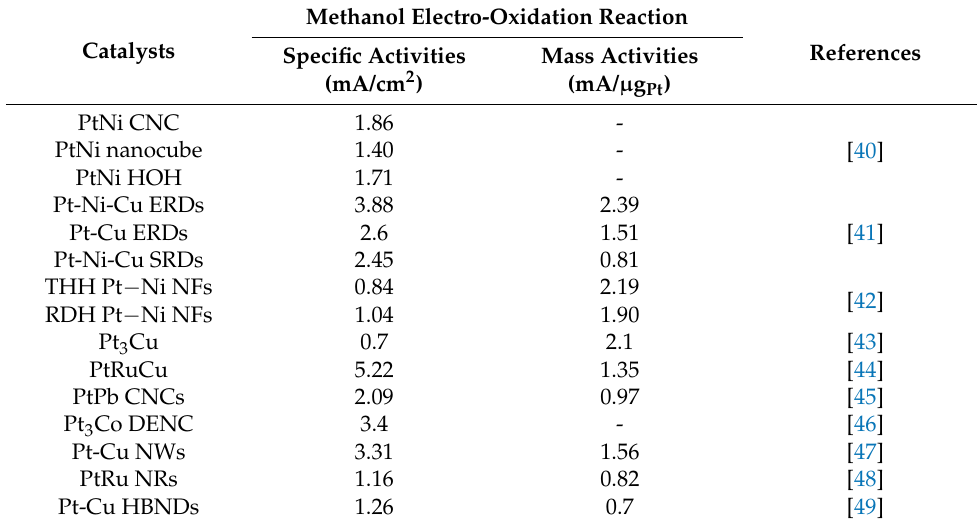
Table 1. Methanol electro-oxidation reaction performances in the other reported literature.